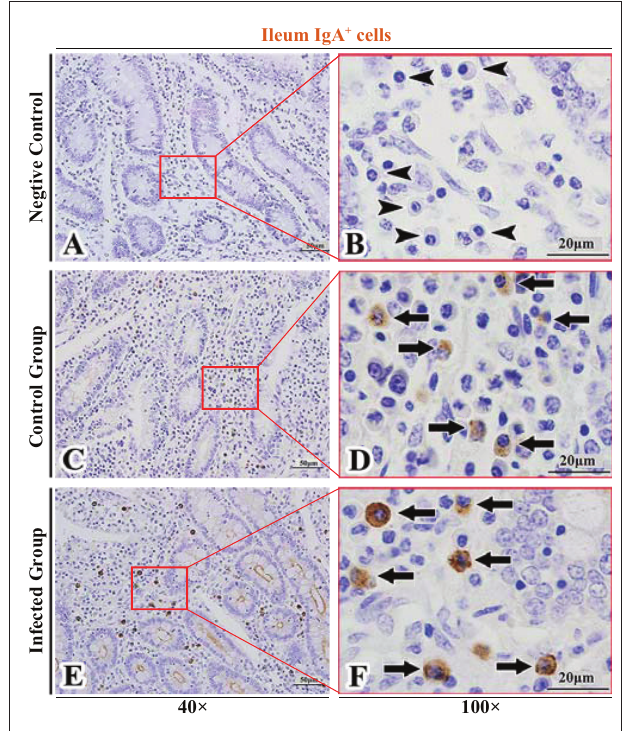
FIGURE 8 | Distribution of IgA + cells in sheep ileum. (A,B) are negative controls; (C,D) are Control groups; (E,F) are Infected groups. Triangular arrows indicated plasma cells, arrows indicated IgA + cells, and the right image (Scale bar, 20 µ m) is a magnification from the part of the left image (Scale bar, 50 µ m). 3A–D , 4A–D ), jejunum ( Figures 5A–D , 6A–D , 7A–D )